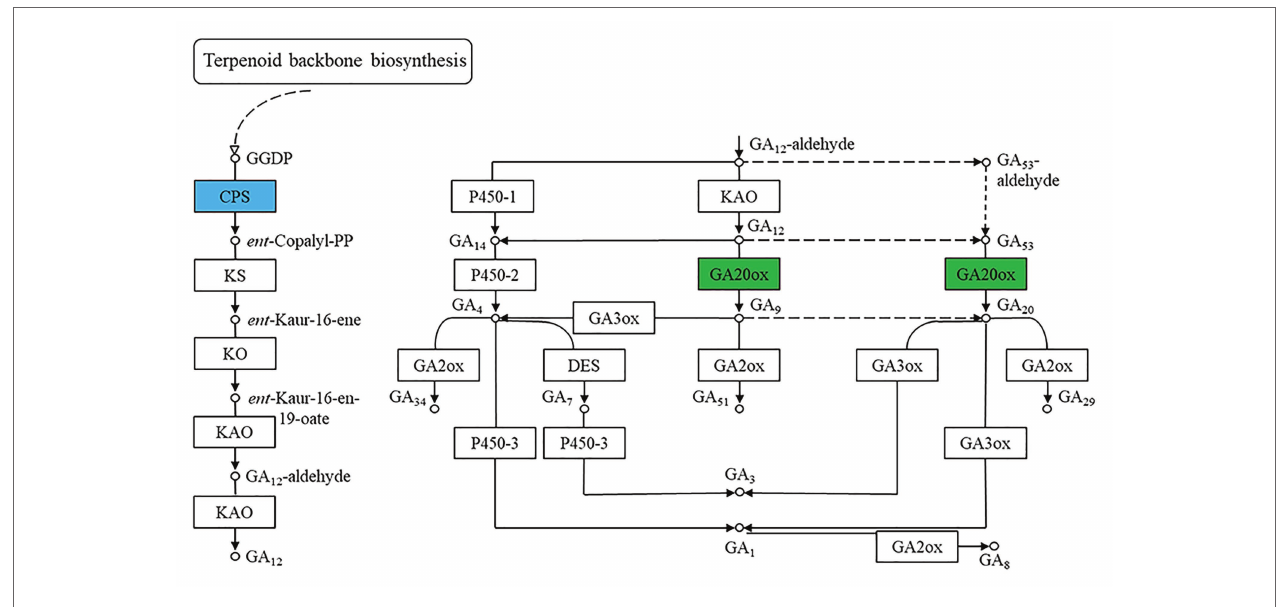
FIGURE 9 | Differentially expressed genes of the gibberellin synthesis pathway. The boxes filled with green represent enzymes containing significantly downregulated DEGs in qd . The box filled with blue represents the enzymes that contained significantly upregulated and downregulated DEGs in qd